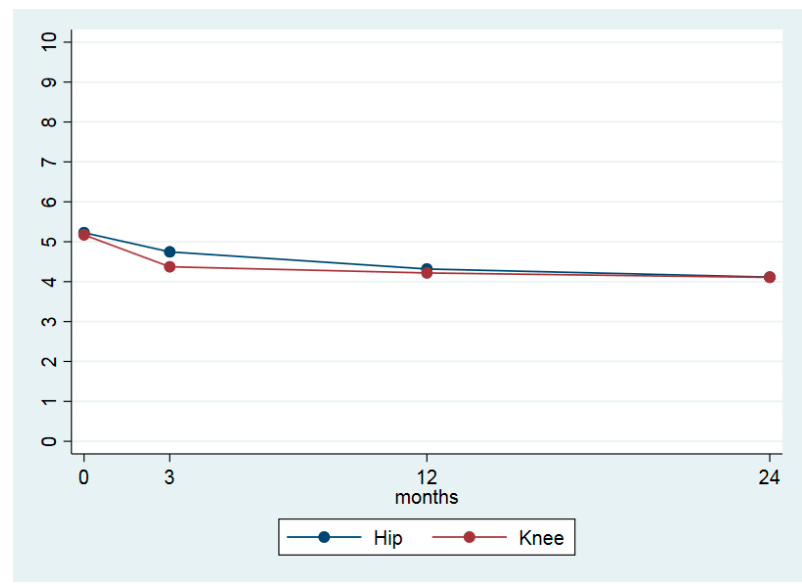
Figure 1. Pain during the last month (numeric rating scale 0–10) at baseline, 3, 12 and 24 months.